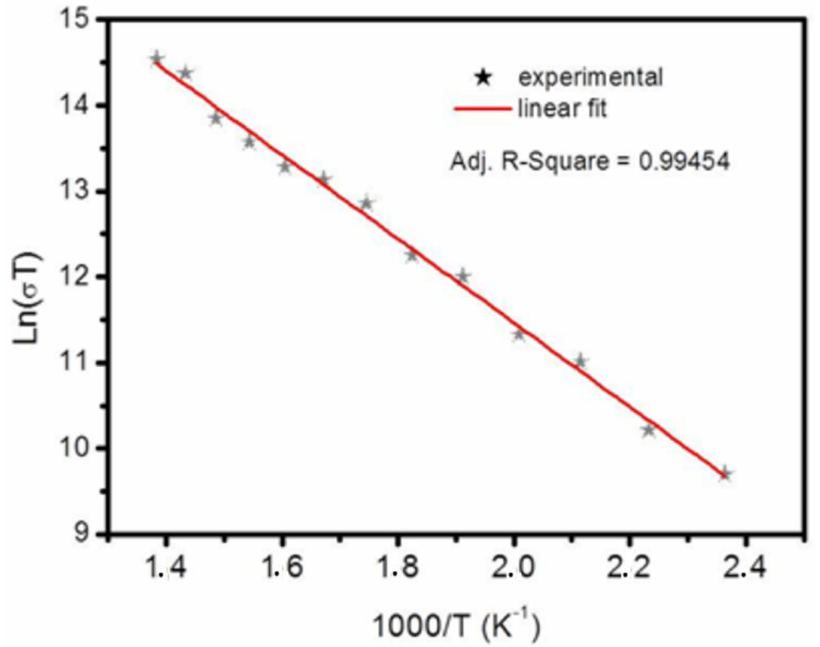
Figure 9. Temperature dependence of DC conductivity σ DC